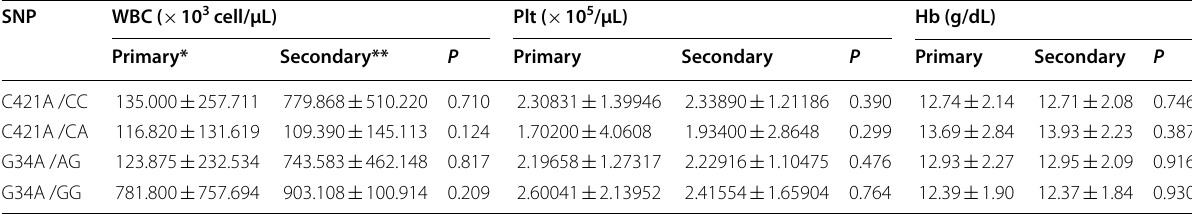
Table 4 The comparison of hematological response between patients with different genotypes